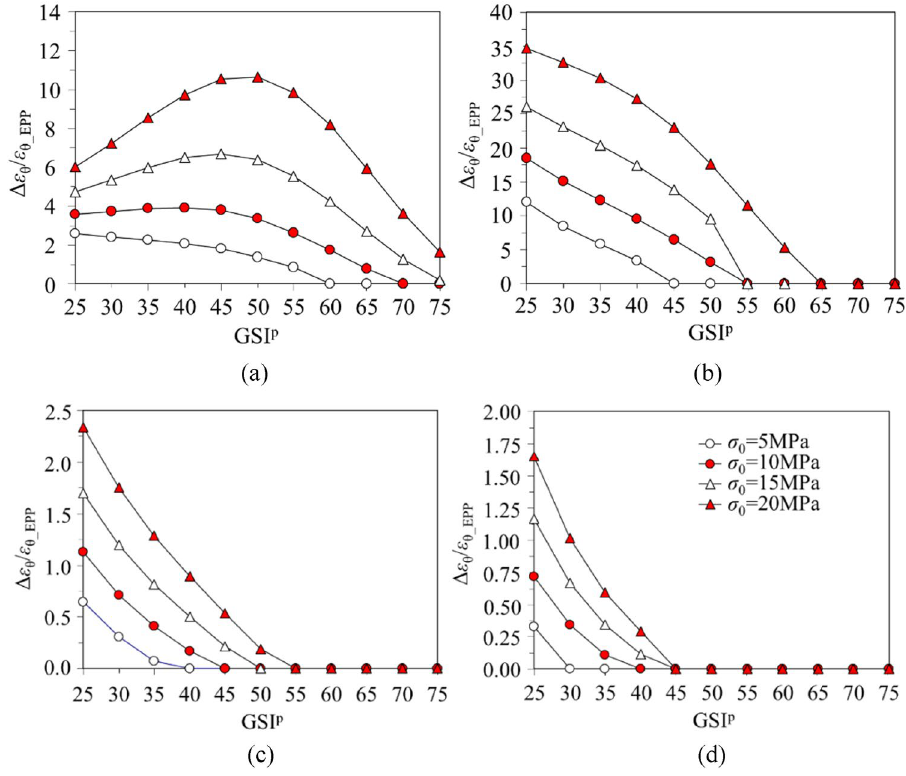
Figure 10. Variation of Δ ε θ / ε θ_EPP versus GSI p : ( a ) p i / σ 0 = 0; ( b ) p i / σ 0 = 0.1; ( c ) p i / σ 0 = 0.2; ( d ) p i / σ 0 =